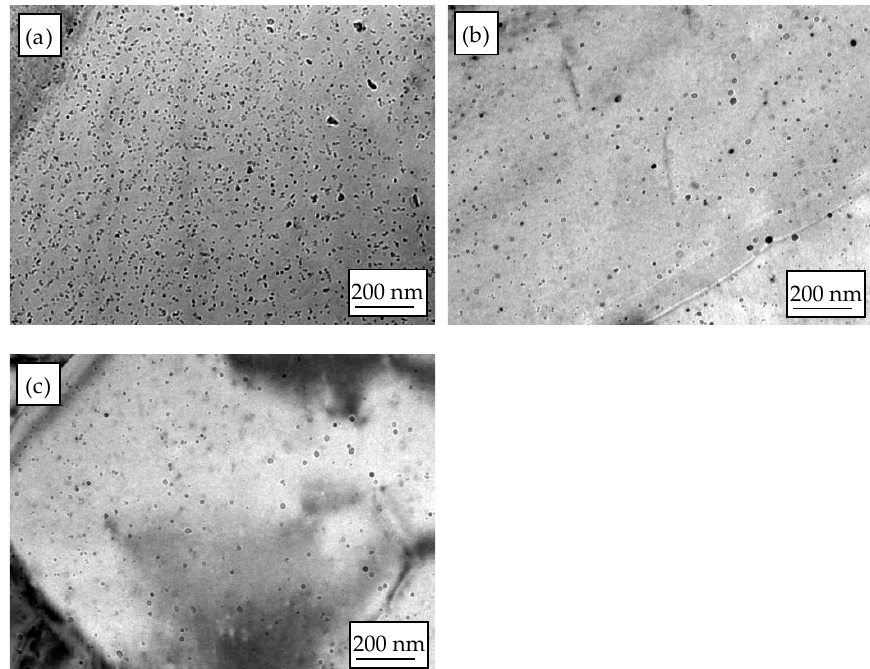
indicated by the black arrows) are uniformly distributed in the ferrite grains (as indicated by the red arrows) in these three samples. The average sizes of the precipitates in the HR, EF1, and EF2 samples are measured using Image Pro Plus software to be 7.5 nm, 12.5 nm, and 13.5 nm, respectively. The effective sizes of precipitates were determined by their area. It can be found that the average of the precipitates gradually increases after enamel firing.